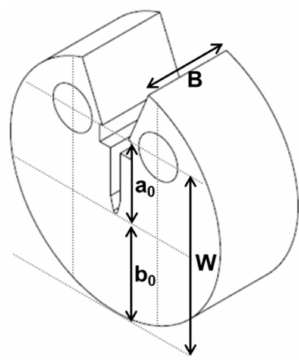
Figure 2. The schematics of the disc compact (DCT) specimen for fracture toughness